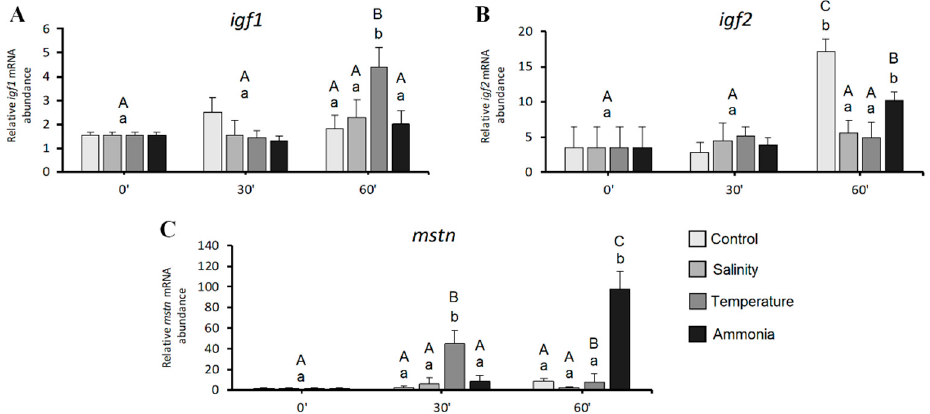
Figure 3. Relative mRNA levels of genes involved in fish growth analysed in seabream juveniles: ( A ) igf1 ; ( B ) igf2 and ( C ) mstn . Data are expressed as mean ± SD ( n = 15). Different letters denote statistically significant differences in time course analysis (lowercase) or within the same sampling point (uppercase) ( p < 0.05).